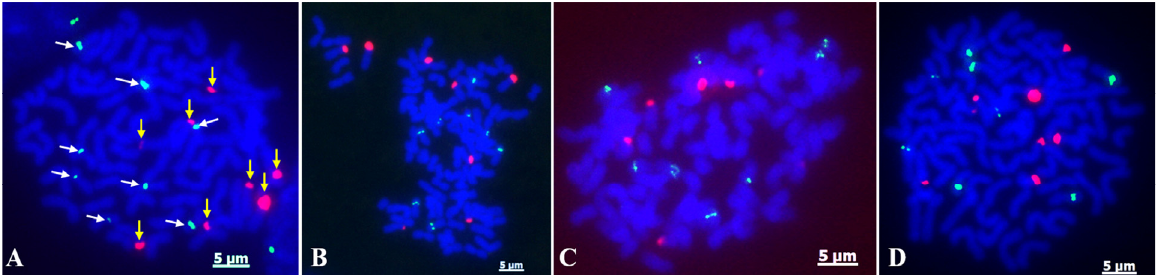
Figure 4. Localization of 5S rDNA and 35S rDNA probes on root–tip metaphase chromosomes of S. officinarum and S. robustum (2n = 8x = 80) by FISH. ( A – D ): Badila-CN; LA Purple; 51NG63; 57NG208, respectively. The 5S rDNA signals are green and indicated by white arrows. The 35S rDNA signals are red and indicated by yellow arrows. Scale bars = 5 µ